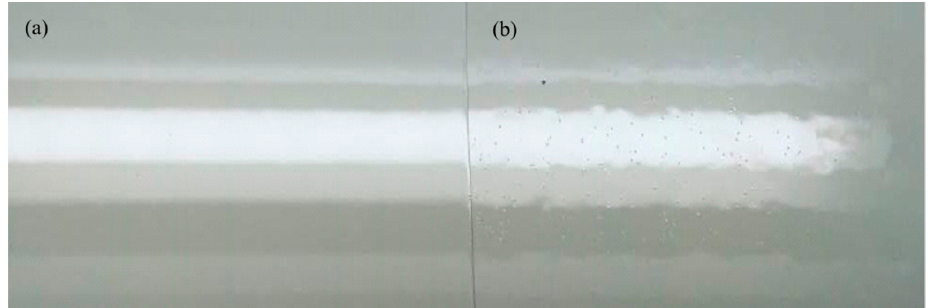
Figure 3. Comparison of the two coatings. ( a ) 1.0% LDBS added; ( b ) no LDBS added.